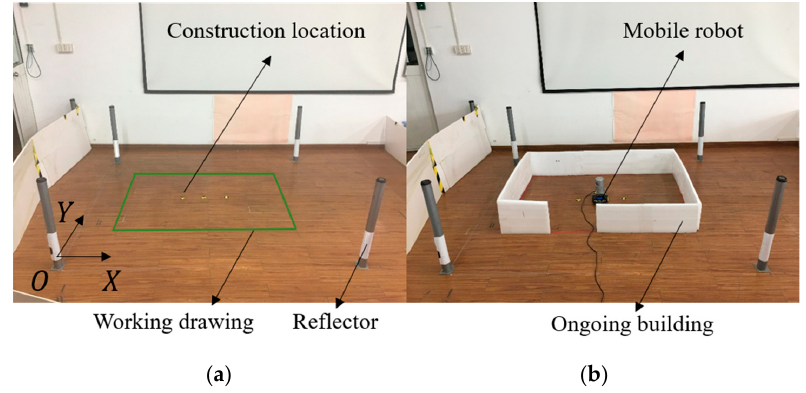
Figure 7. Diagram of experimental indoor construction site. ( a ) The initial working location; ( b ) the completed site of the ongoing scene.